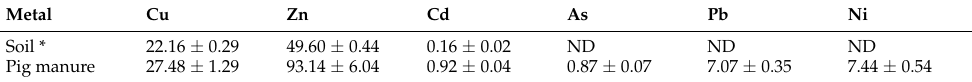
Table 1. Background heavy metal content in original soil and pig manure (mg/kg dry weight). Metal